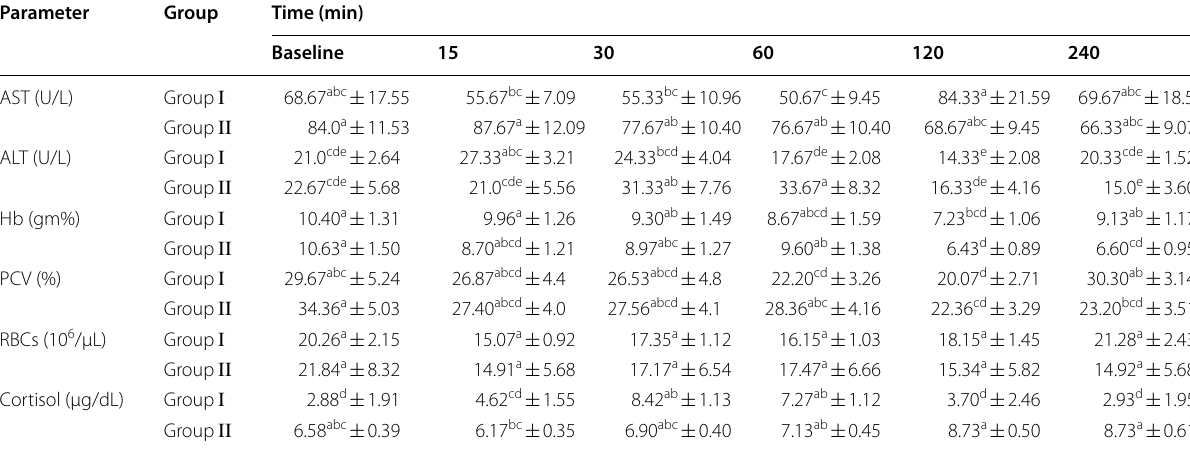
Table 4 Mean standard deviation (SD) of hematobiochemical parameters at different time intervals ±